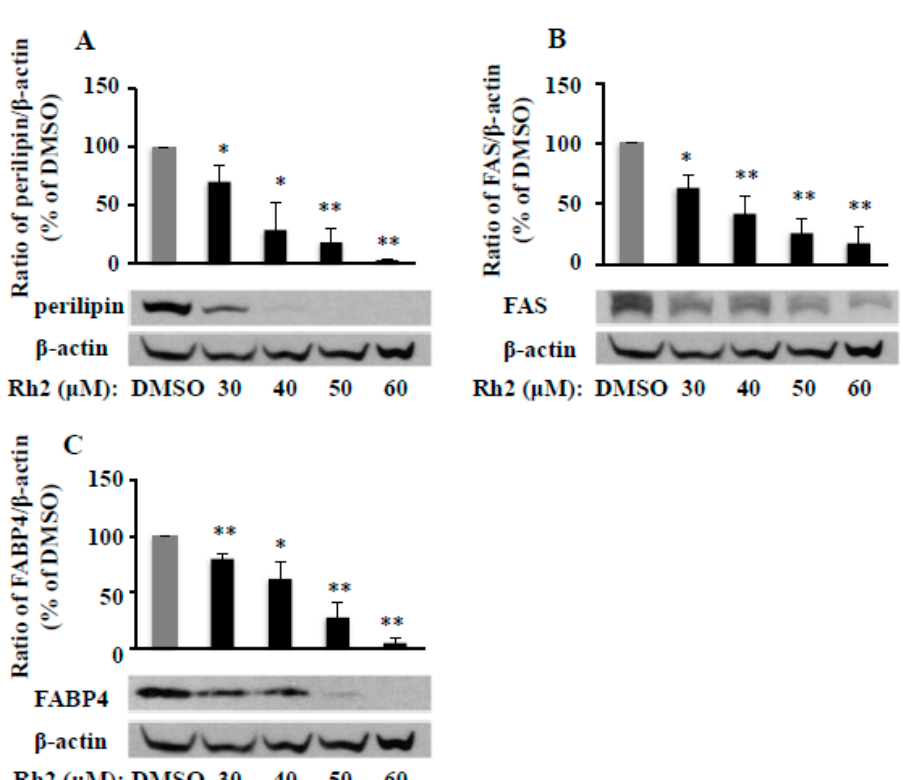
Figure 4. Ginsenoside Rh2 dose-dependently attenuates protein expressions of fat packing proteins perilipin ( A ), fatty acid synthase (FAS, B ), and fatty acid binding protein 4 (FABP4, C ) in 3T3-L1 cells. On day 7, cells treated with various concentrations of Rh2 were collected to measure perilipin, FAS, and FABP4 protein expressions by Western blot and normalized by β -actin expression. Values are means ± SE, n = 3. A set of representative images and bar graphs are shown. * p < 0.05, ** p < 0.01 vs. DMSO.